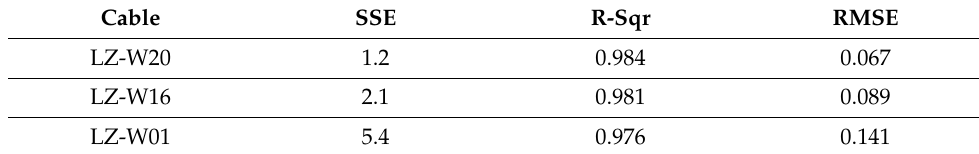
Table 10. Sample parameters from 17 August 2018.